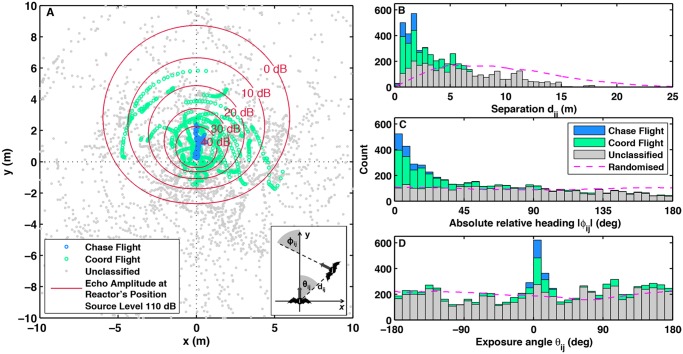
Bats’ relative locations with corresponding sound fields and summary statistics of all co-flying bats.Panel (A): relative positions of co-flying bats with reactor’s sound fields. Symbols indicate locations of one individual relative to the position (centred) and heading (upwards) of the other: blue for chases, green for coordinated flights, and grey for unclassified behaviour. In the latter case, the individual at the centre is picked at random for each pair. Reactor is in the centre with upward heading with symbols showing actor’s positions and with red lines representing isocontours of the reactor’s calculated echolocation field. Parameters: cosine directionality with front-rear difference of 36 dB accounting for both emission and hearing directionality (see Equation (11) below). Source level is 110 dB [29] and absorption is 1.28 dB m−1[22]. Inset indicates separation distances d
ij, relative headings ϕ
ij, i.e. the angular difference between the two velocity vectors, and exposure angles θ
ij, i.e. the angular position of the actor with respect to the heading of the reactor. Panel (B), (C), and (D) display histograms of separation distances, absolute relative headings and exposure angles of co-flying bats obtained from panel (A).